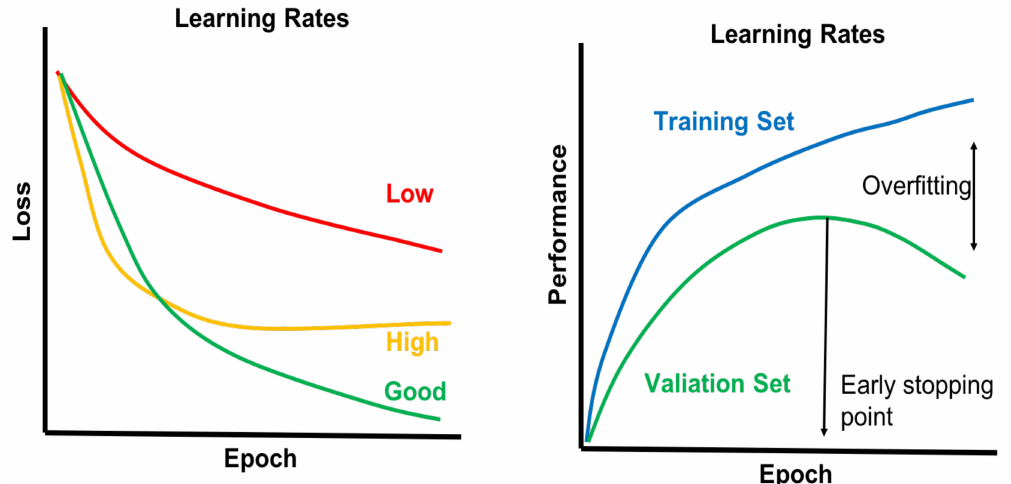
Figure 12. Loss function and performance metric over epoch to avoid the overfitting problem of deep networks. When the model performance of a validation set diminishes relative to the performance of a training set, an overfitting scenario may be